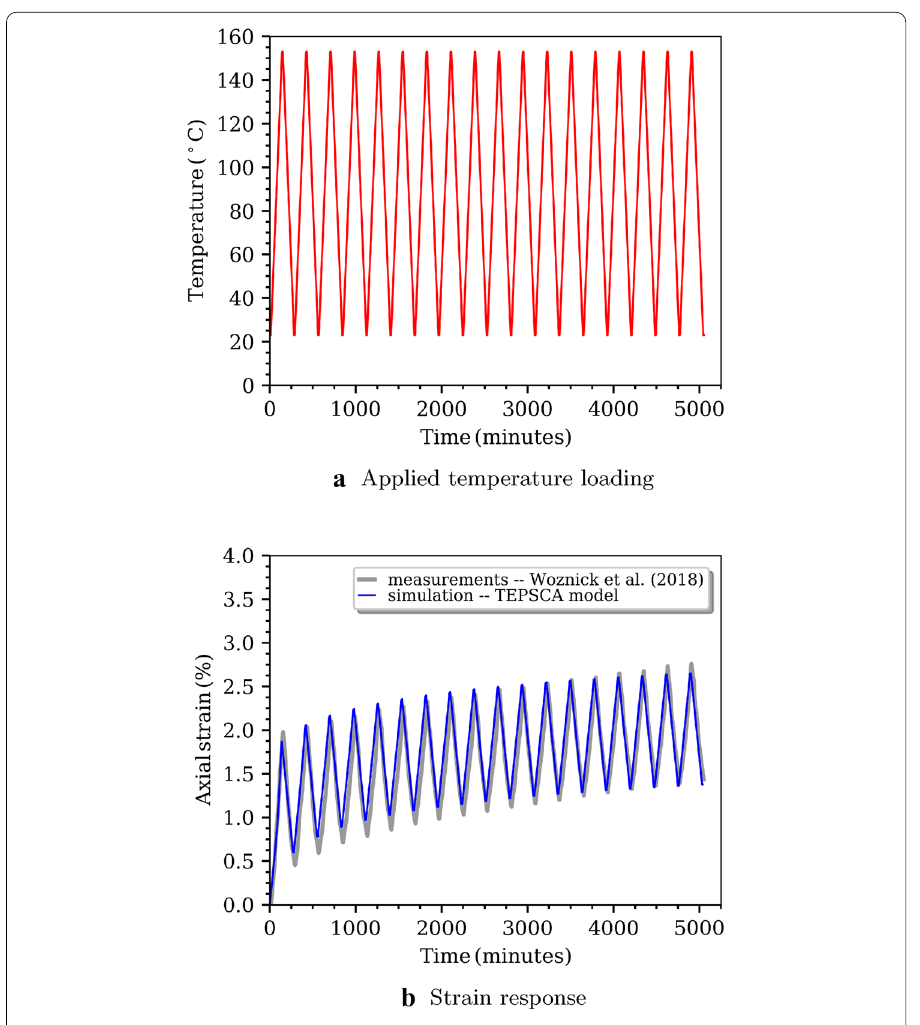
Fig. 6 Comparison of TEPSCA simulations of the ratchet growth of a TATB pellet to the measurements of Woznick et al. [65]: a temperature load was cycled from 23 to 153 ◦ C at a rate of 1 ◦ C/min a total of 18 times with 10 min hold times at maximum and minimum temperatures, and b TEPSCA simulation results are compared with measured strain response